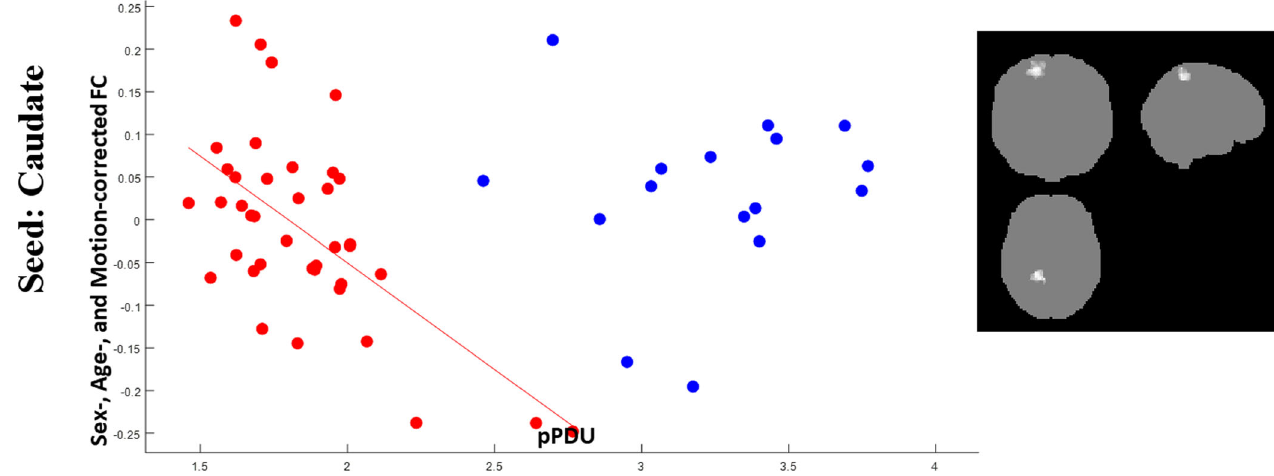
Fig. 4 Correlations of post-central cortex FC with pPDU. Scatterplots for PD (red) and ET (blue) patients of the mean FC of the cluster (highlighted in the inserts on the right, the most affected side is at reader ’ s left) showing a signi fi cant correlation of the caudate FC ( y axis) with pPDU ( x axis) in PD patients. FC of the caudate on the MAS with the homolateral superior parietal cortex shows an inverse correlation with pPDU in PD patients, with no signi fi cant correlation in ET patients in the same